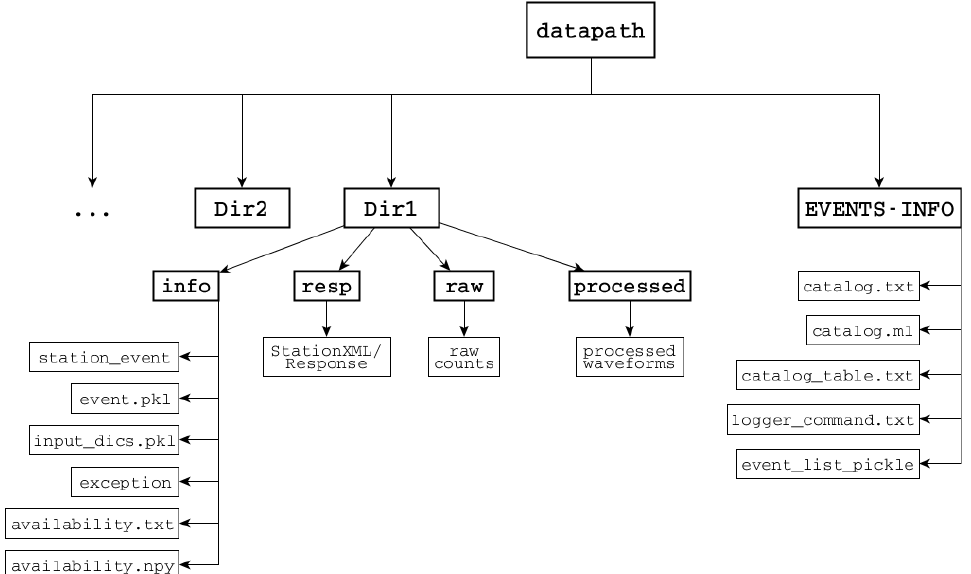
Figure A1. For each request, obspyDMT creates the depicted directory tree inside the user-specified directory datapath/ and arranges the retrieved data either in event subdirectories (for event-based requests) or in chronologically named subdirectories (for continuous requests). It also creates a subdirectory EVENTS-INFO/ in which a catalog of all requested events or time spans is stored. Earthquake metadata (date and time, latitude, longitude, depth, magnitude, moment tensor, source time function) are stored in CSV and QuakeML formats (files catalog.txt , catalog.ml ). The file catalog_table.txt organizes basic event information (latitude, longitude, depth, date and time, magnitude) in a table. Raw waveforms, StationXML/response files and corrected waveforms are collected in subdirectories. During the data retrieval process, obspyDMT also creates metadata log files about retrieved station and event files, stored in the info/ subdirectory of each event